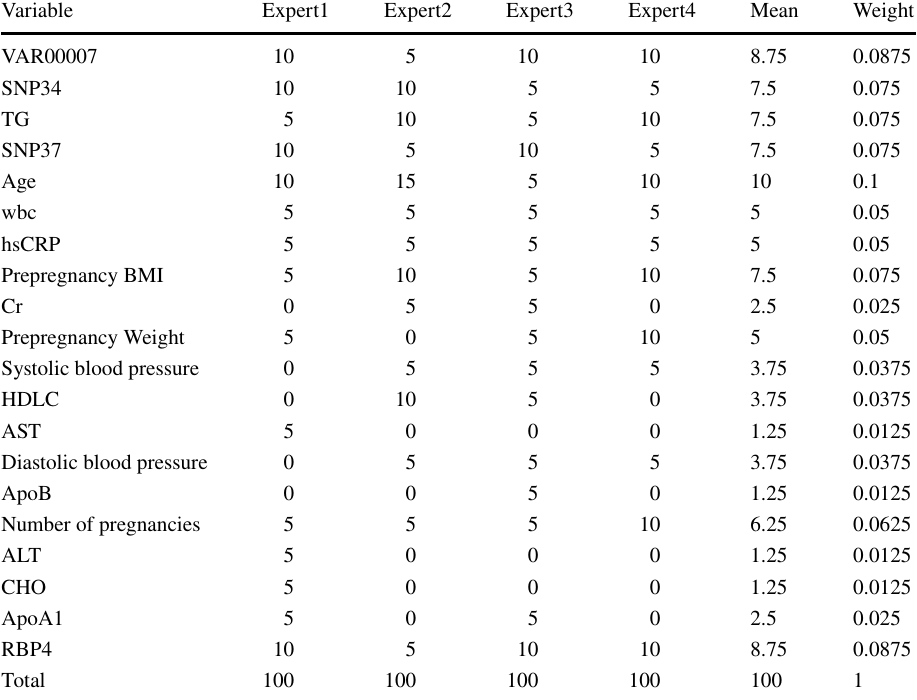
Table 5 Variable weight based on expert